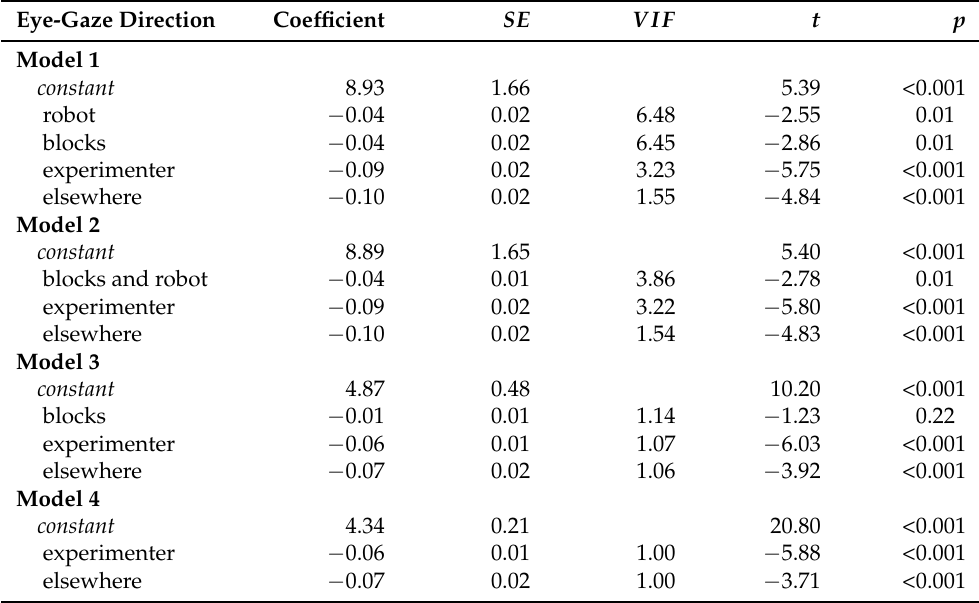
Table 3. Regression analyses summary for the duration (s) that children looked in different directions predicting children’s task